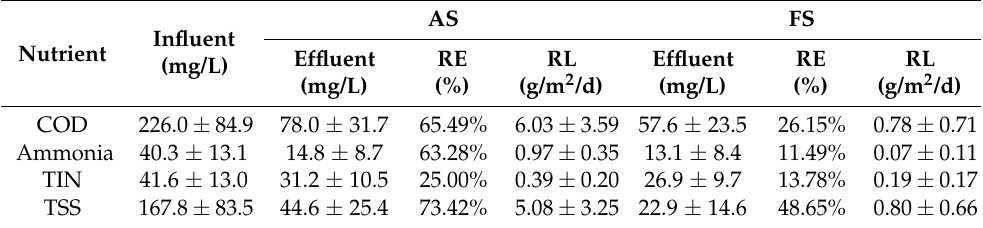
Figure 3. Digital photos of biofilm on the carriers in ( a ) aeration section and ( b ) filtration section. Table 2. Nutrients concentrations and removal loading in influent and different sections.